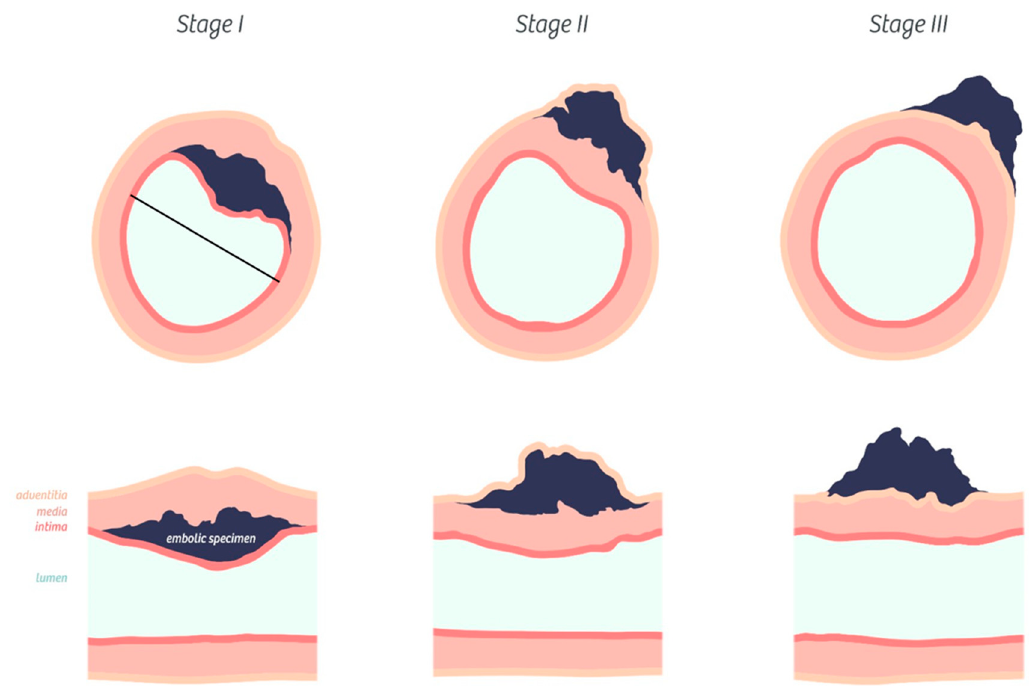
Figure 2. Classification of pulmonary artery angiophagy. Embolic specimen progression through the pulmonary arterial wall is shown in axial cuts (upper row) and in a longitudinal cut (lower row). The black line represents the estimated shortest pulmonary artery diameter measurement in case of concentric remodeling.